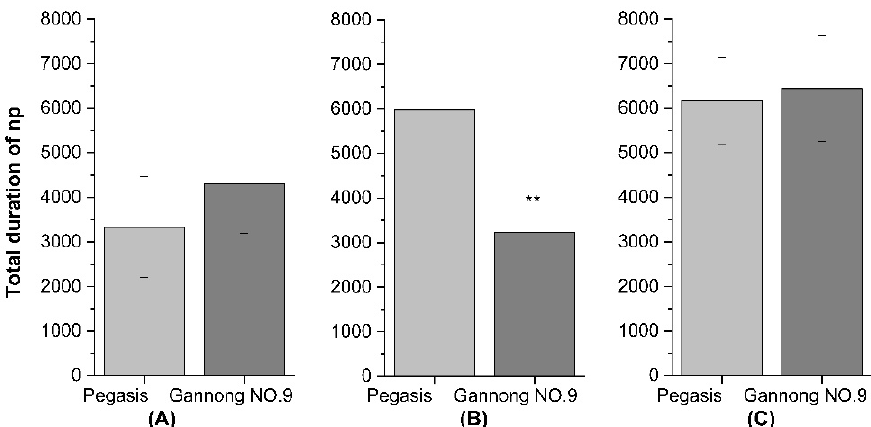
Figure 5. Total duration of no penetration activity (np) of ( A ) cowpea aphid (CPA), ( B ) pea aphid (PA), ( C ) spotted aphid (SAA) (** Indicates the difference is significant, p < 0.05).